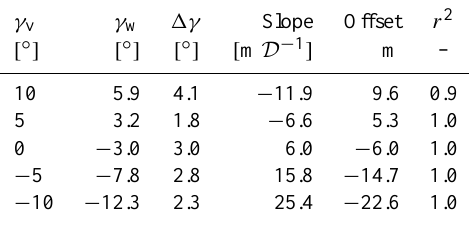
Table 3. Results of estimation of yaw misalignment ( γ w ) by lin- ear regression through last three points of the near-wake path (1.0, 1.2, and 1.4 D ). The data have been classified in 5 ◦ bins with respect to nacelle vane ( γ v